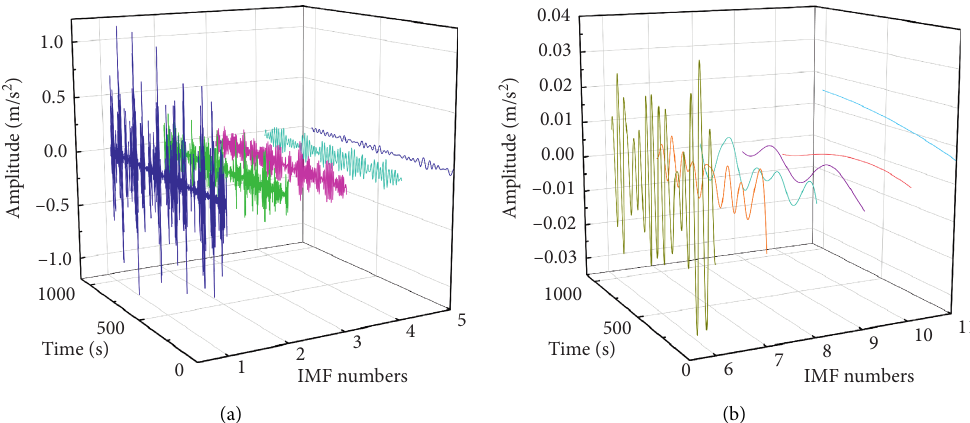
Figure 12: The ten IMFs generated by UPEMD of the fan end channel signal of the bearing’s first working condition.